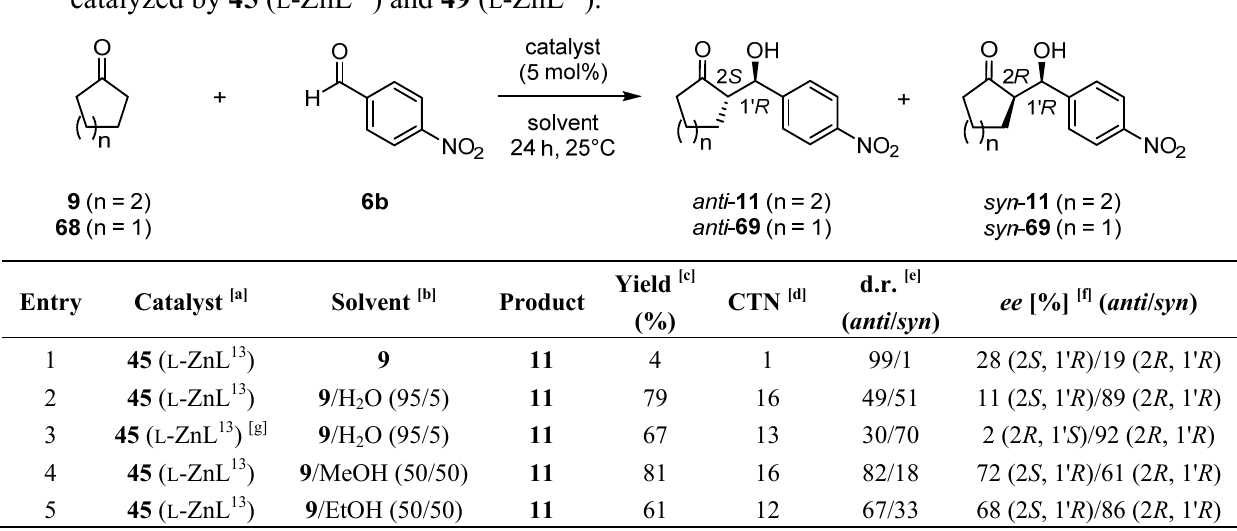
Table 8. Results for asymmetric aldol reactions between cyclic ketones ( 9 and 68 ) and 6b catalyzed by 45 ( L -ZnL 13 ) and 49 ( L -ZnL 17